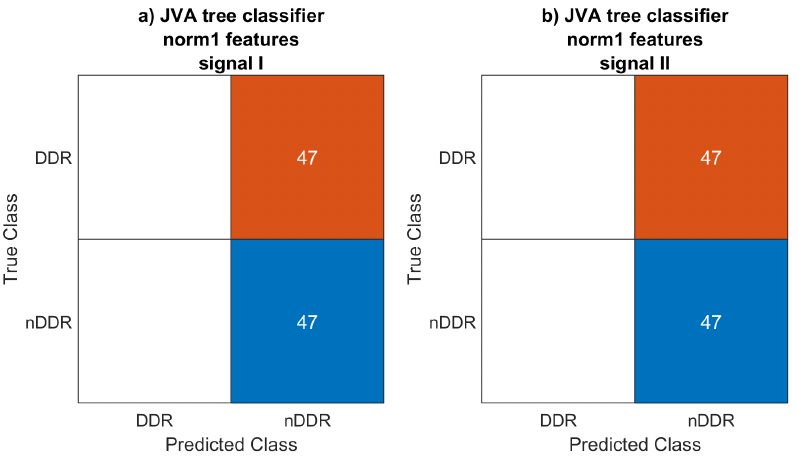
Figure A8. Confusion matrices for norm1 features used in the JVA decision tree classifier for the ( a ) first and ( b ) second signals.